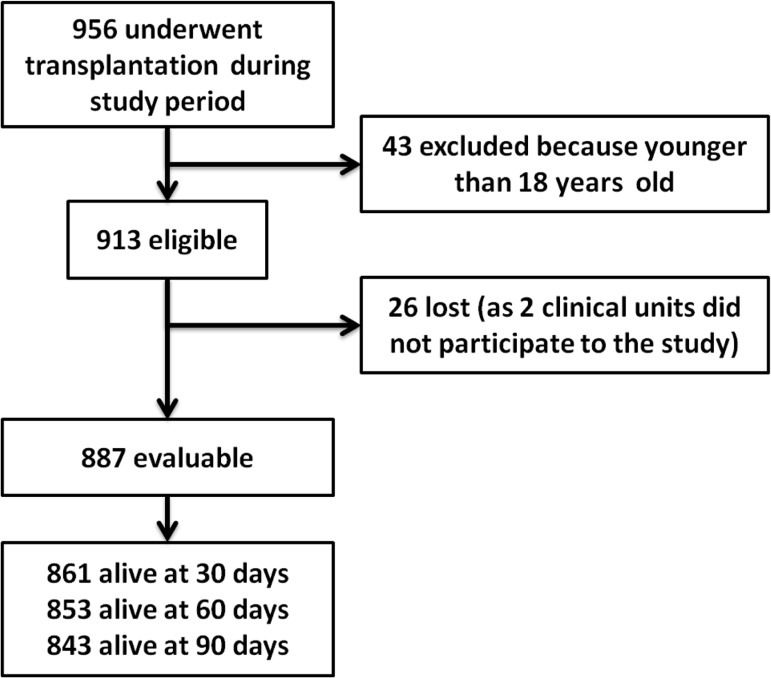
Study flowchart.